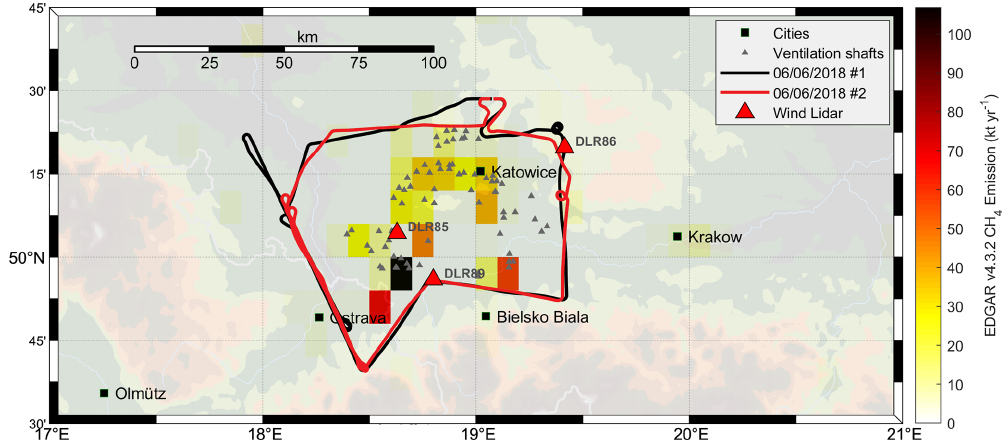
Figure 1. Flight trajectories of two flights of the German Aerospace Center (DLR) Cessna 208B sampling the USCB area during the CoMet field campaign. The plot shows flight trajectories for the morning flight (black) and afternoon flight (red) on 6 June 2018. Red triangles mark the location of three Doppler wind lidars, deployed in the USCB area during the CoMet campaign. Gray triangles mark known coal mine ventilation shafts. Colored tiles are from the EDGAR v4.3.2 CH 4 emission inventory for 2012, showing typical emissions ranging up to ∼ 100ktyr − 1 .